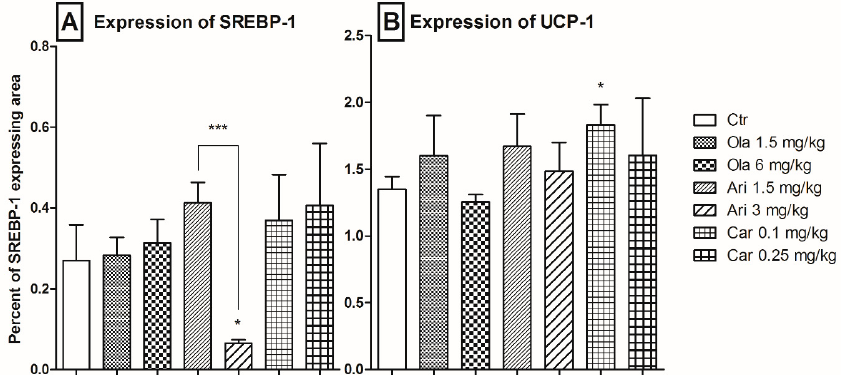
Figure 4. Adipose tissue protein levels of SREBP-1 ( A ) and UCP-1 ( B ). Values represent the percent of SREBP-1 expressing area in sections (quantified as positive reaction). A striking decrease of SREBP-1 can be observed in case of the high dose Ari treatment compared to Ctr, and there is a highly significant difference between the two doses of Ari ( A ). A significant increase in UCP-1 expression can be observed after low-dose Car treatment ( B ). Significant differences are noted with * ( p < 0.05) and *** ( p < 0.001).